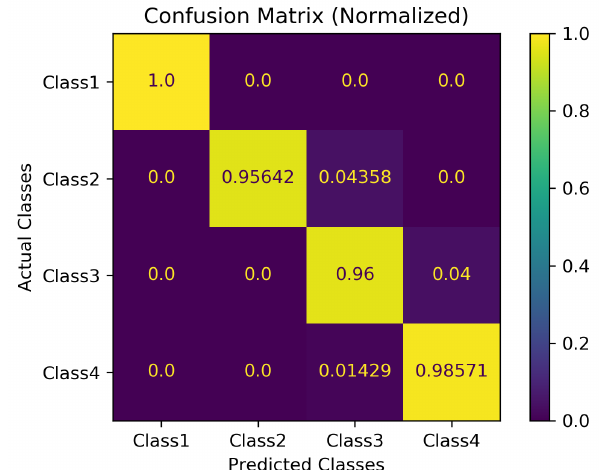
Figure 20. The normalized confusion matrix for 100 runs using 20 videos of the testing set. Classes 1, 2, 3, and 4 indicate unipedal stance, 8 ft up and go, 30 s chair stand, and 2 min step,